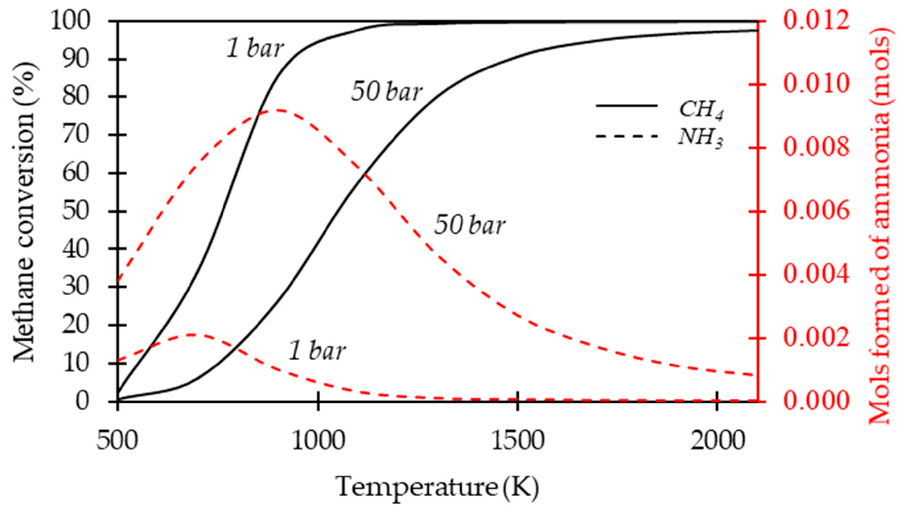
Figure 8. Combined effects of nitrogen addition to the feed with pressure on process behavior.